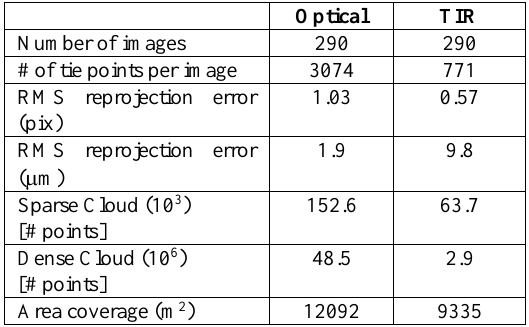
Table 1 Average photogrametric statistics of all